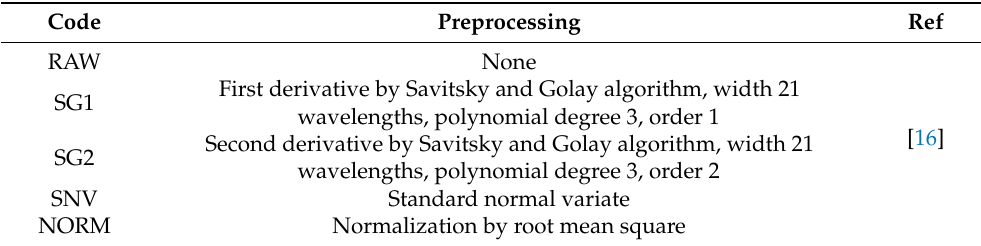
Table 2. Preprocessing methods applied to fluorescence and absorbance spectral